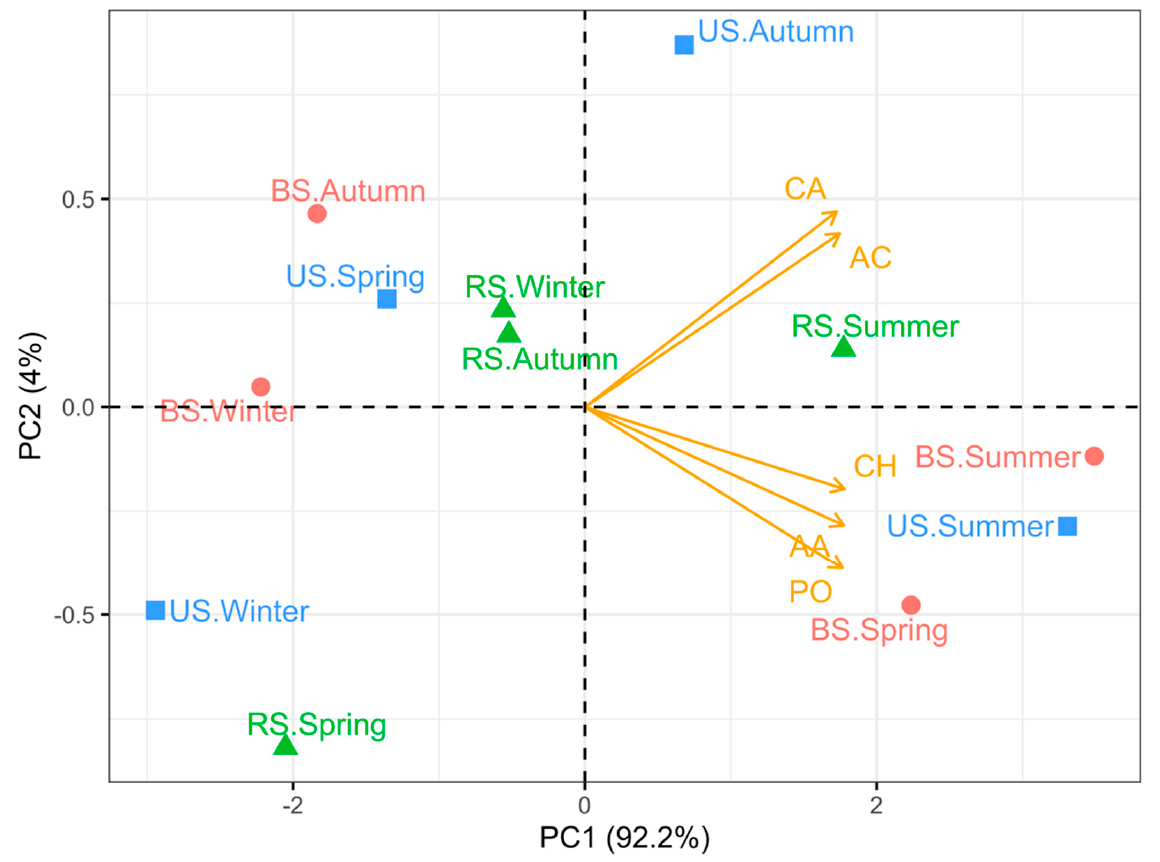
Figure 9. Principal component analysis (PCA) of carbon source utilization profiles of soil microorganisms in cultivated and uncultivated land. There was an apparent difference in carbon source utilization patterns for soil microbiomes in each season. Abbreviations: BS—bulk soil; RS—rhizo-